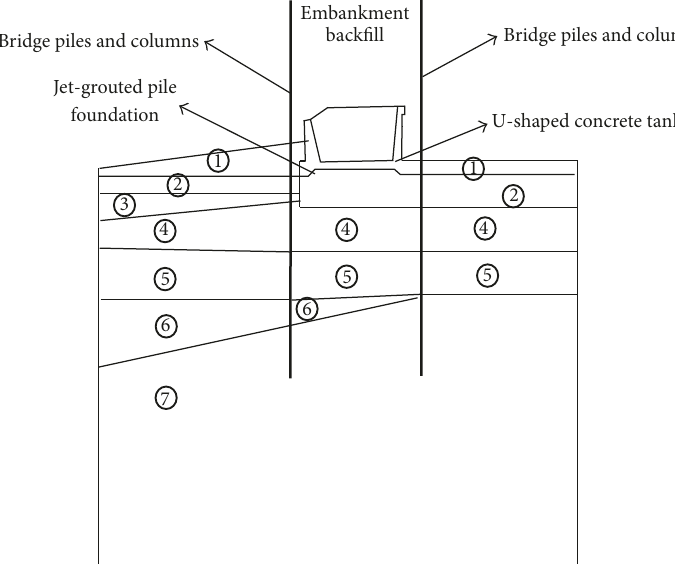
Figure 17: Soil layer distribution and calculation model.